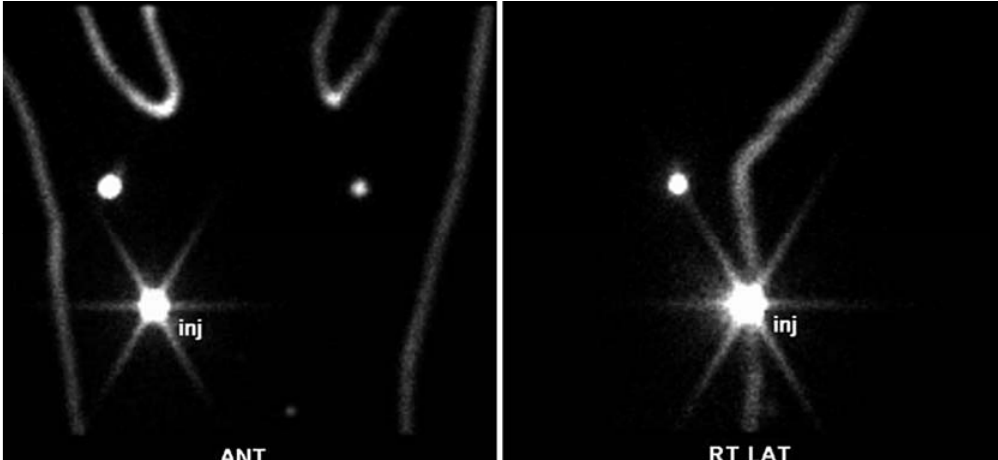
Figure 2. Aberrant drainage to the contralateral axilla and not on the ipsilateral axilla. ANT, anterior; RT, Right; LAT, lateral.